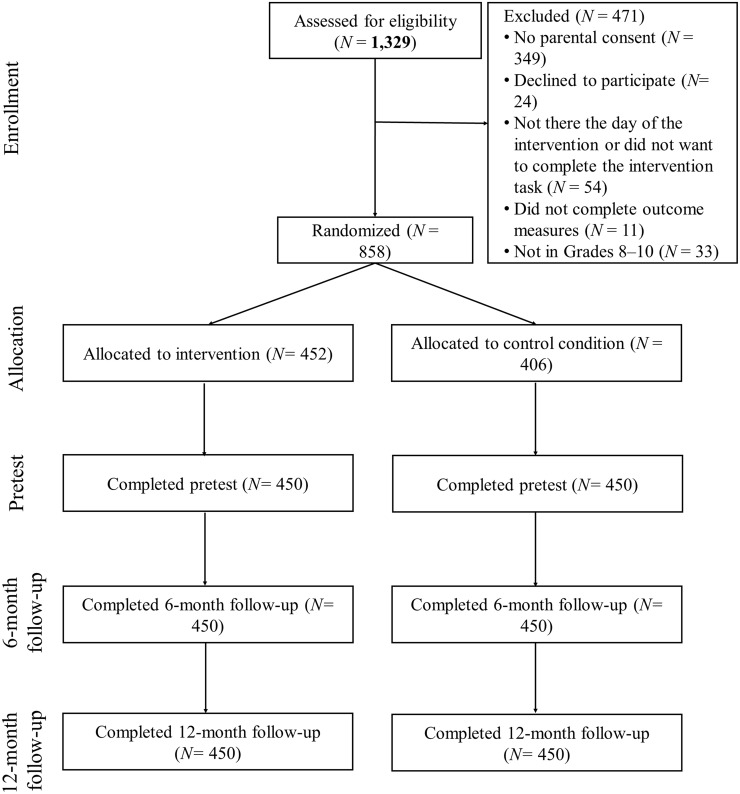
CONSORT diagram.